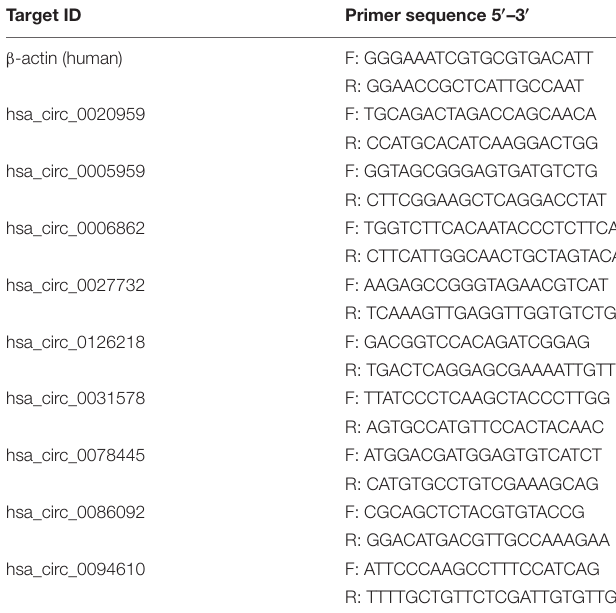
TABLE 2 | Primer used for qRT-PCR analysis of circRNAs expression